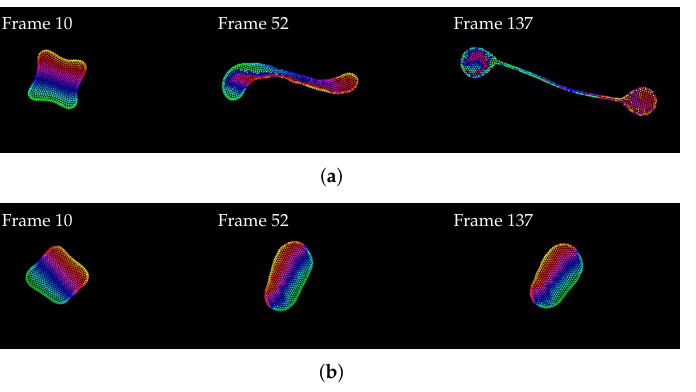
Figure 5. Angular momentum in the process of rotation. The related video has been submitted as Supplementary Material. ( a ) With angular momentum (our method). ( b ) Without angular momentum.